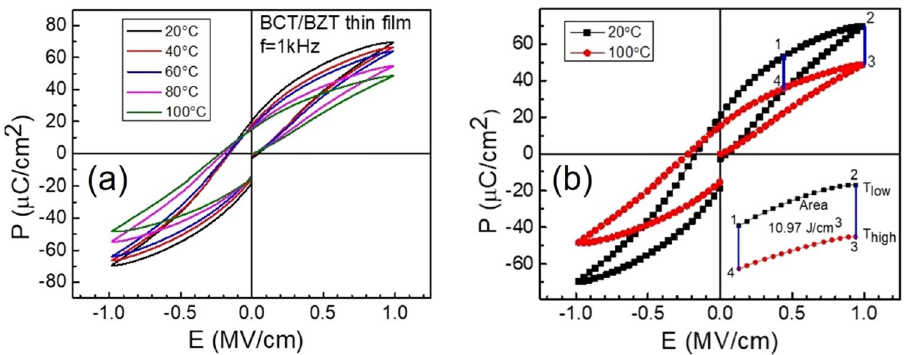
Figure 6. Variation of polarization with electric field (P–E) hysteresis loops of BZT/BCT films at the frequency of 1 kHz at different temperatures ( a ). Sketch of the pyroelectric Ericsson cycle in four-step on a ferroelectric P–E loops at two temperatures ( b ).